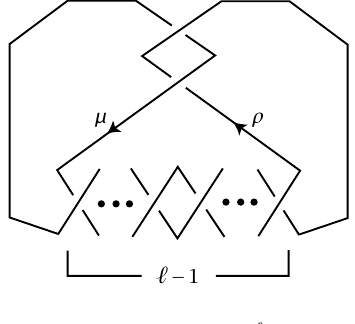
Figure 3.1 . The knot ((cid:2) + 1 ) 1